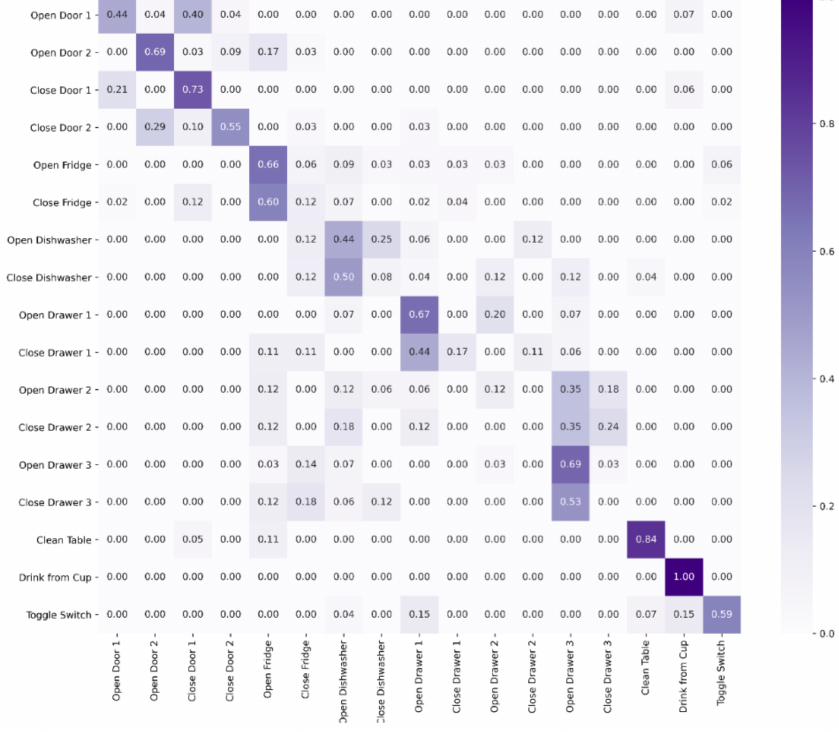
Figure 9. Confusion matrix of the model on testing dataset without NULL